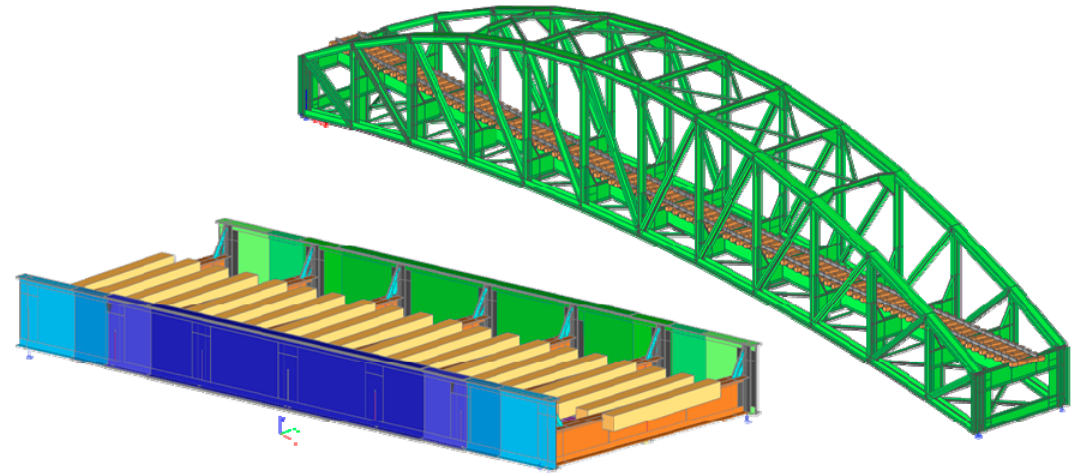
Figure 9. Global view at the FEM models of Bridge 1 (bottom left) and Bridge 3 (top right).